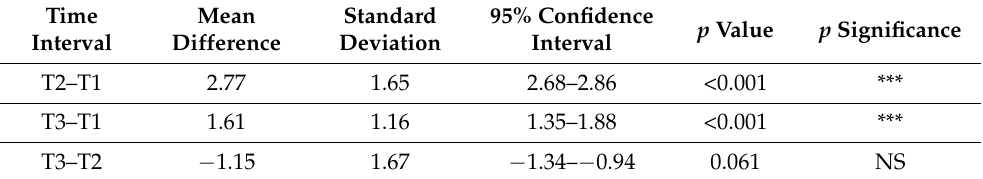
Table 5. Results of the mean differences (mm) of Nasal Width 3 in the three time intervals. Time